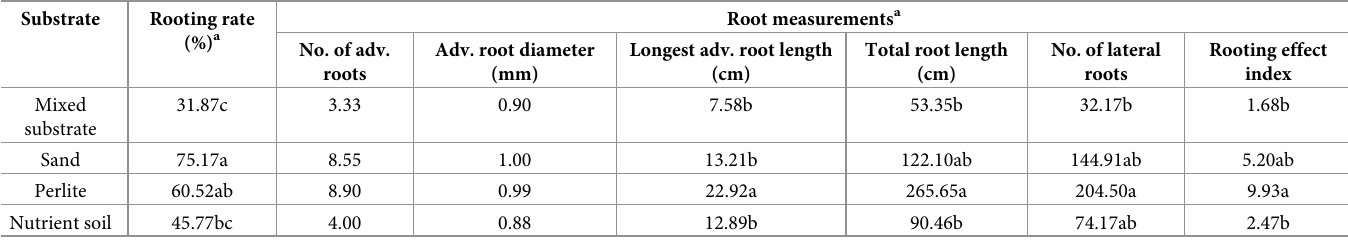
Table 2. Effect of substrate on the rooting rate and other root related traits of PWD resistant stem cuttings. Substrate